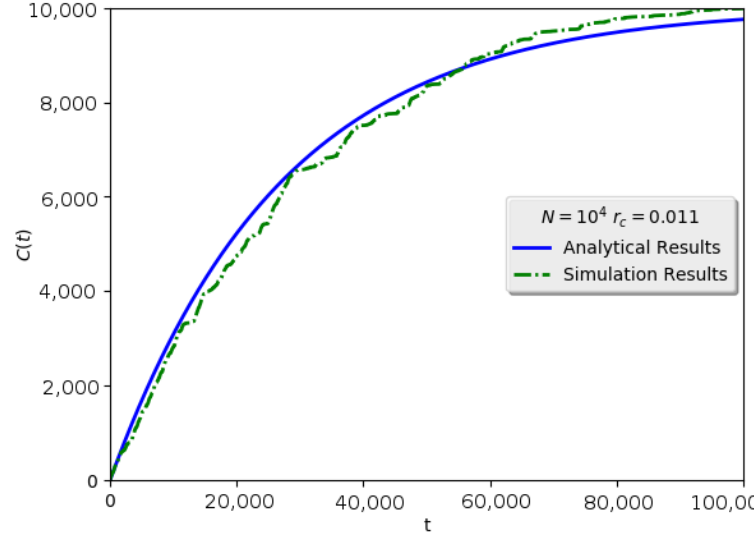
Figure 9. Simulation results for the grid geometric network (green dashed line), N = 10 4 , r c = 0.011, mean number of neighbors = 4. Coverage is depicted over the number of time steps. There is a strong correlation between the analytical part and the simulation one.